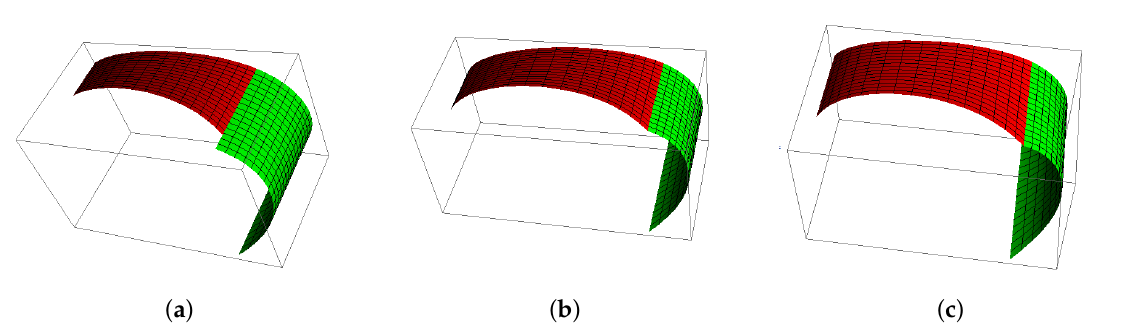
Figure 11. G 3 continuity of developable GHT-Bézier